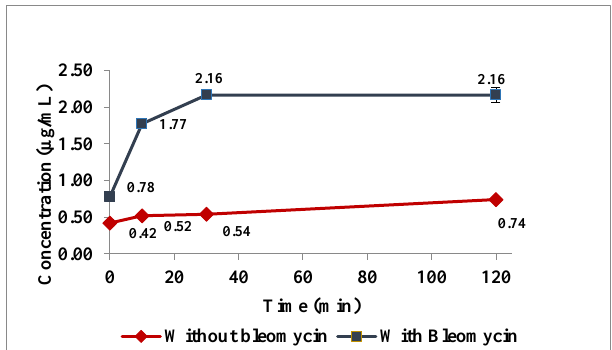
Figure 3. Chelation effect of Bleomycin in in-vivo samples.